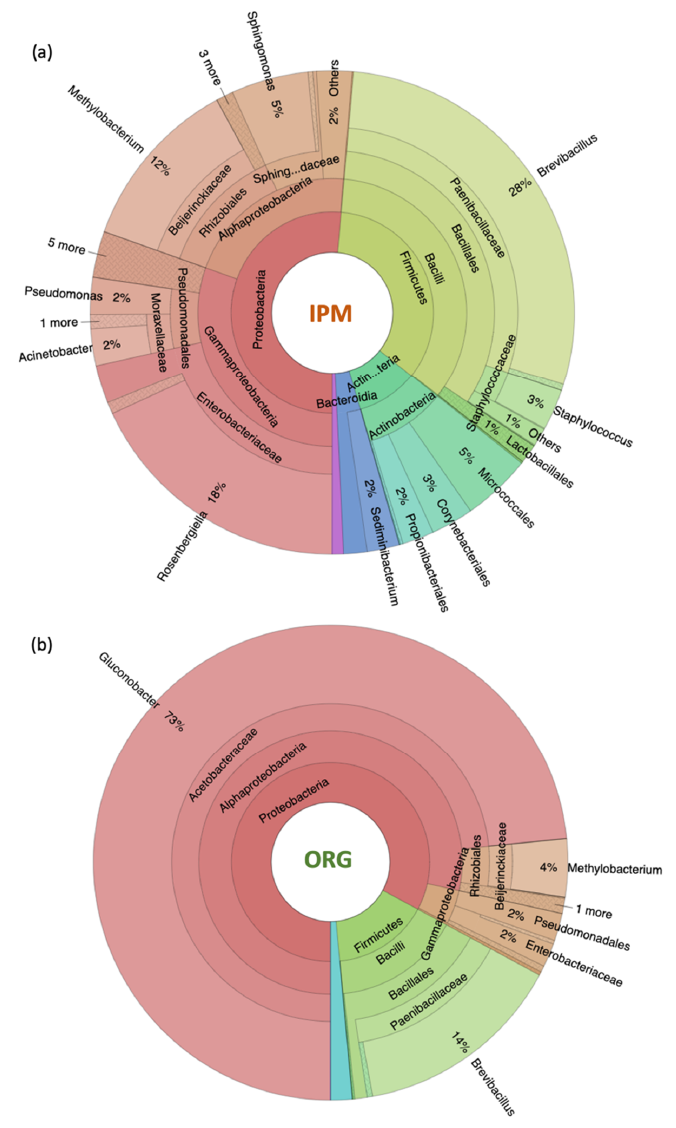
Figure 1. Krona chart showing bacterial community composition at phylum, order, class, family and genus level for ( a ) integrated pest management (IPM) and ( b ) organic raspberry fruits ‘Enrosadira’.